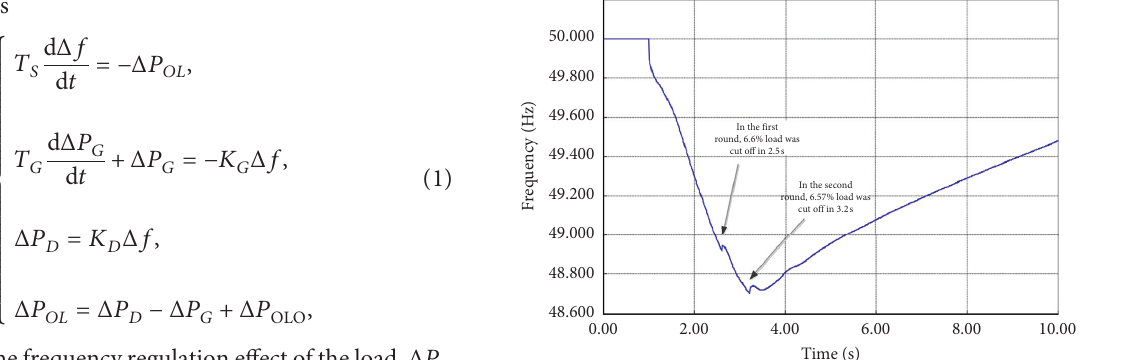
Figure 3: Frequency characteristic curve after low-frequency load